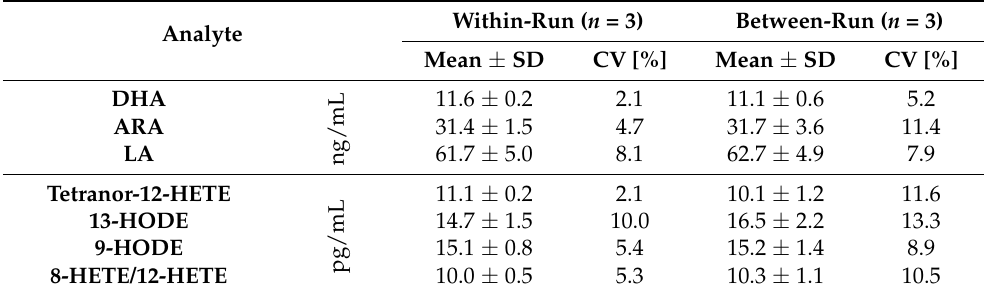
Table 1. Within-run ( n = 3) and between-run ( n = 3) variability of PUFAs and eicosanoids in an extracted EV pool sample.